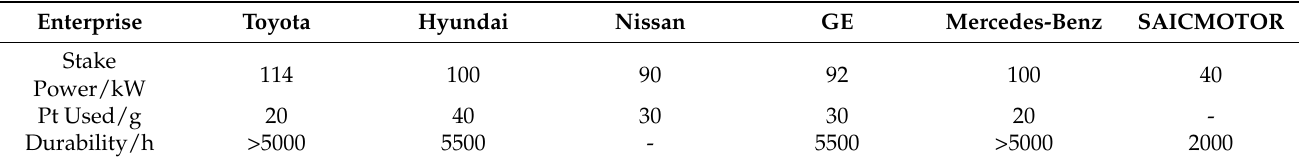
Table 4. Power, Pt consumption, and durability of various fuel cell vehicle enterprises